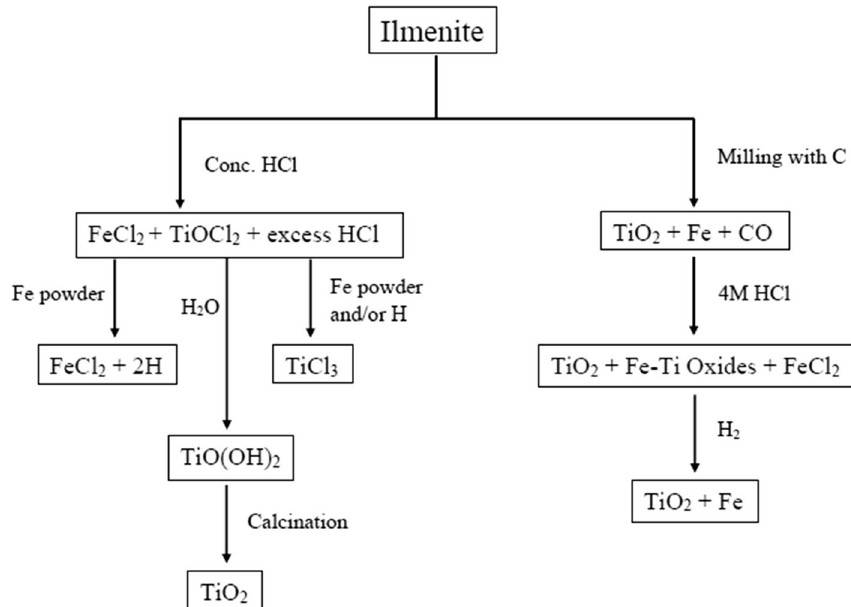
Fig. 2 The flow chart of syn- thesizing TiO